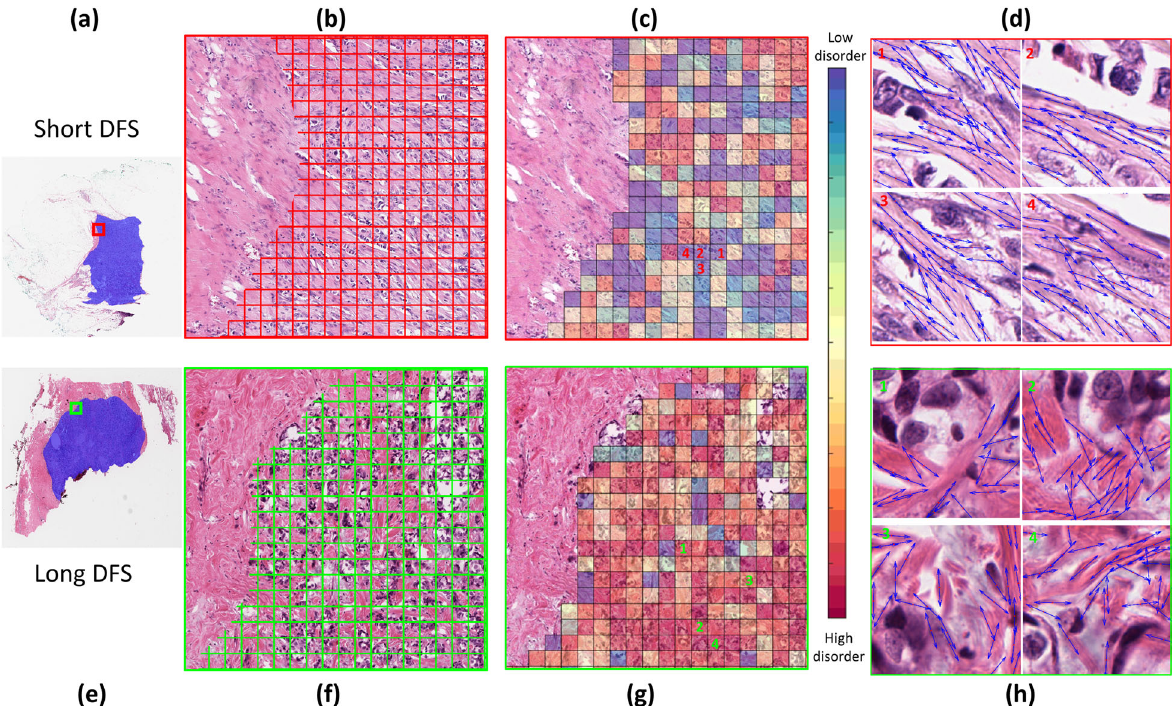
Fig. 2 Representative WSI of breast cancer tissue for patients with short DFS (top row) versus long DFS (bottom row). The fi rst column ( a , e ) showed the original H&E stained WSIs with tumor mask (blue) overlaid. The second column ( b , e ) showed the magni fi ed tumor region at the leading edge, which was compartmentalized into a grid of smaller tumor neighborhoods of 50 um × 50 um. The third column ( c , g ) illustrates the quanti fi ed CFOD-TS in each individual tumor neighborhood within the tumor region in ( b ) and ( f ), where a warm color illustrates a higher feature value (higher disorder degree of fi ber orientations); The fourth column ( d , h ) illustrates the organization of the collagen fi ber orientations (the orientations indicated by the blue arrows) in the tumor-associated stroma in representative tumor neighborhoods (position of each tumor neighborhood was indicated by the corresponding number on ( c ) and ( g )). The patient with short DFS was characterized by a more aligned and ordered collagen fi ber organization, while the patient with long DFS presented a higher degree of disorganization of collagen fi ber